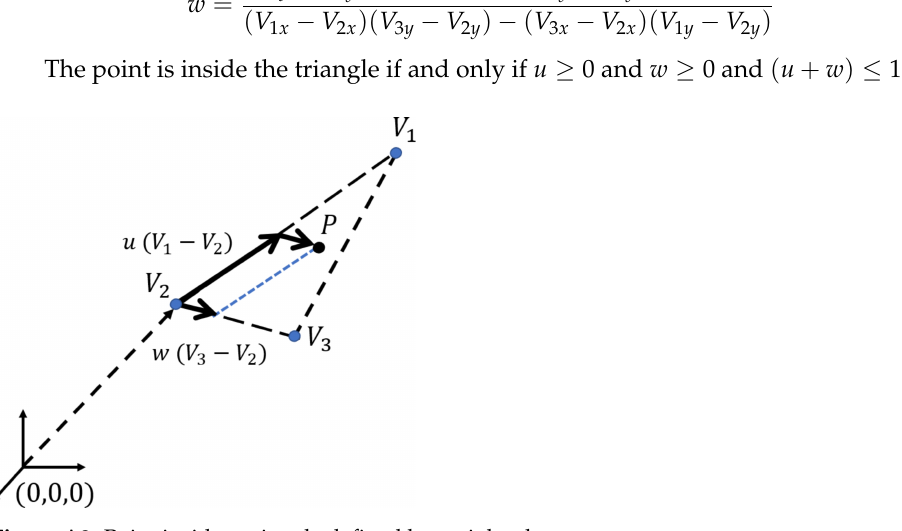
Figure A3. Point inside a triangle defined by weighted